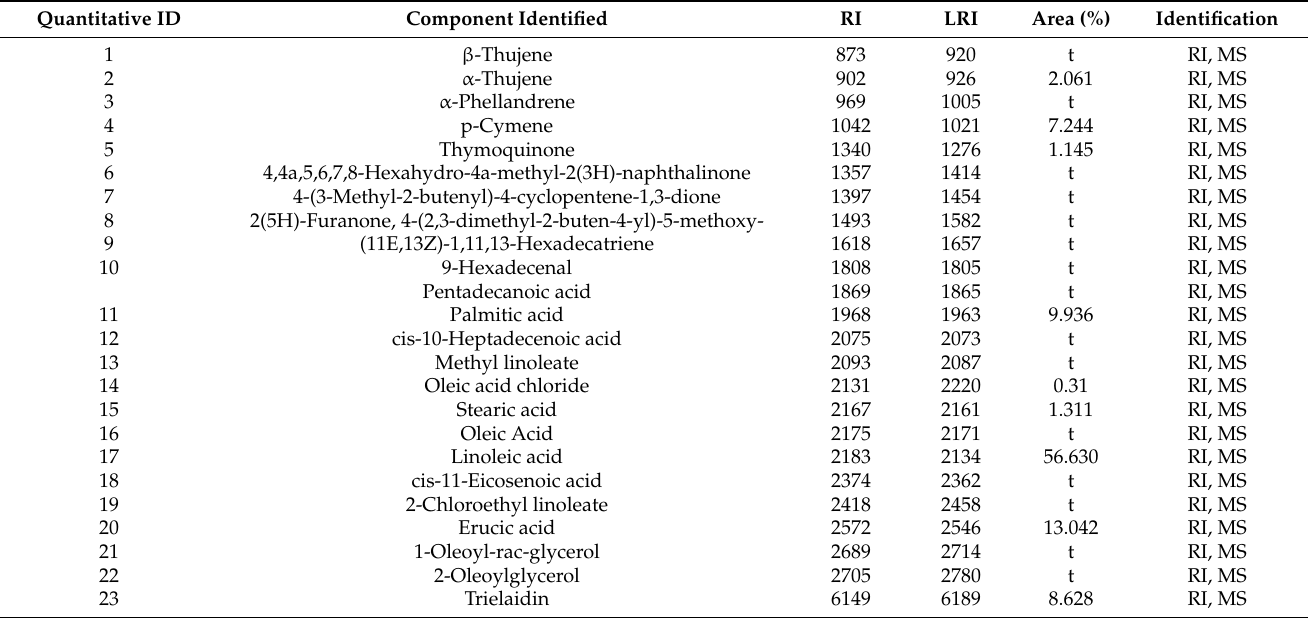
Table 4. Chemical composition of N. sativa